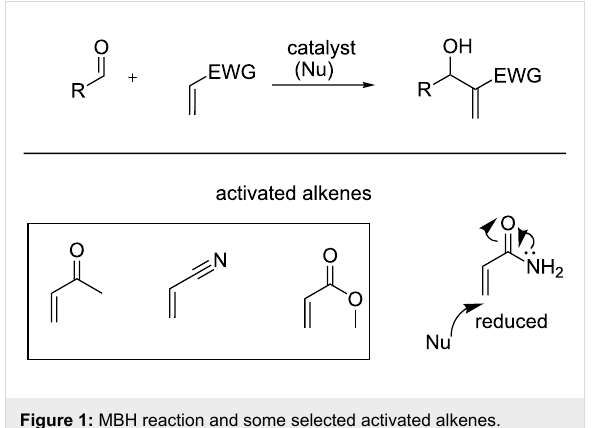
Figure 1: MBH reaction and some selected activated